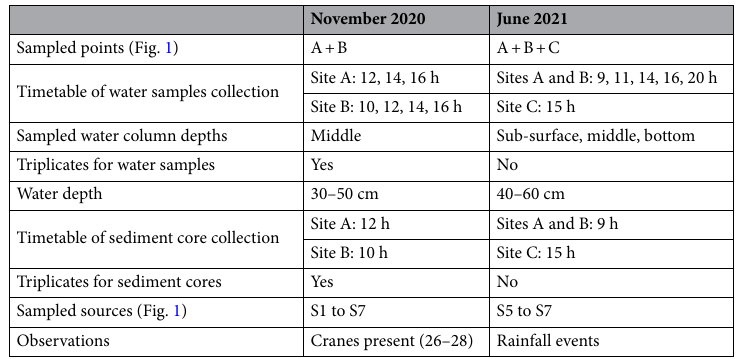
Table 1. Sampling campaigns. Detailed information on the type of samples collected on each